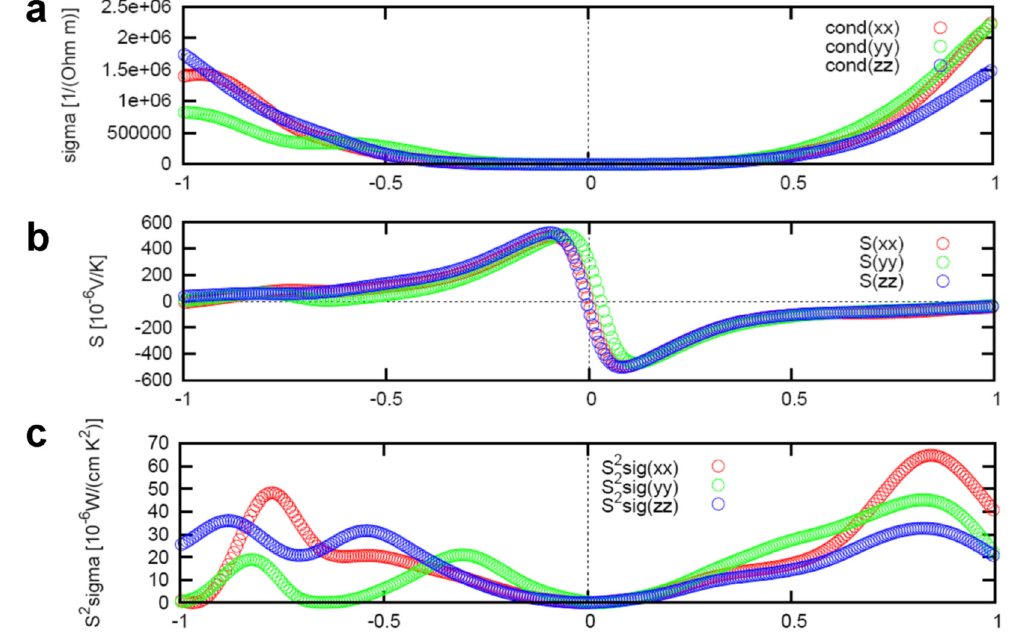
Figure 9. Boltzmann transport calculation result of the ( a ) electrical conductivity σ , ( b ) Seebeck coefficient (cid:1845) , and ( c ) power factor (cid:1845) (cid:2870) σ with respect to chemical potential μ of the In 4 Se 3 −δ ( δ = 0.25) compound under fixed conditions of temperature T = 600 K and relaxation time of scattering τ = 2.2 × 10 − 14 s. Reproduced with permission from Nature publishing Group, 2009